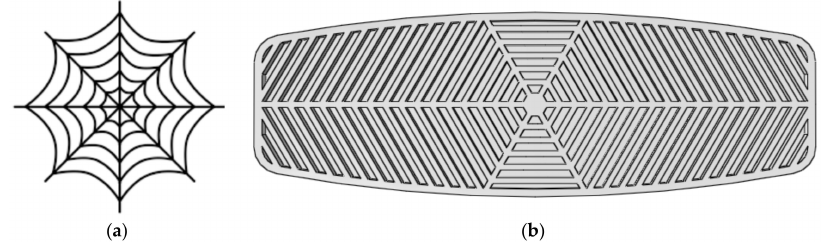
Figure 19. ( a ) A schematic of a spiderweb; ( b ) The spiderweb-inspired pattern applied to the core of the